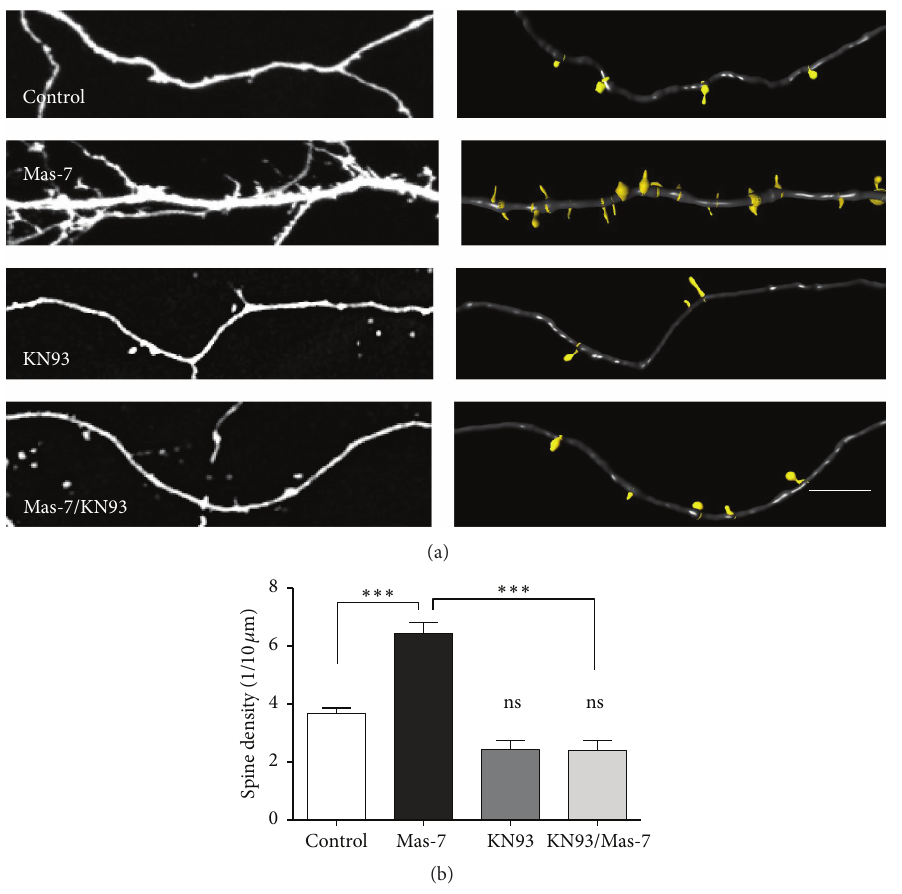
Figure5:Mas-7inducedspinogenesisthroughtheactivationofCaMKII.(a) Leftpanel ,representativeimagesof14DIVhippocampalneurons untreated (control) or treated with or without Mas-7 for 2h and coincubated with KN93. Right panel , representative 3D reconstructions. (b) Quantification of dendritic spine density for all of the conditions ( 𝑛 = 4 ). Scale bar = 5 𝜇 m. ∗∗∗ 𝑝 < 0.001 . ns = no significant difference.